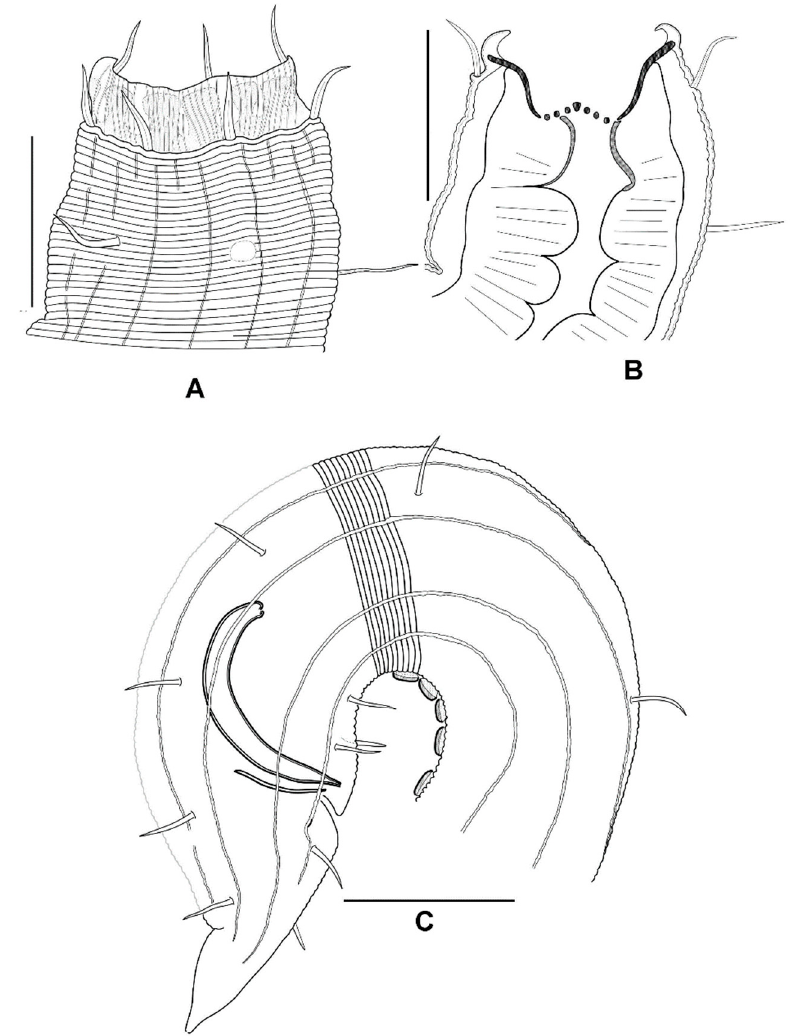
Figure 9. Latronema obscuramphis sp. n., male holotype structures: ( A ) surface view of the head; ( B ) sagittal optical section of the head; ( C ) posterior body. Scale bars: 20 μ m.